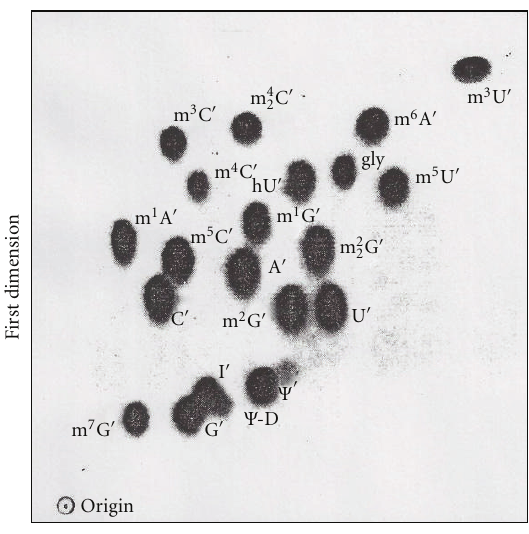
Figure 5: Two-dimensional map of standard nucleosides [9]. The [ 3 H]-labeled standard nucleoside derivatives are separated by two- dimensional thin layer chromatography. The first dimension is shown from bottom to top and the second dimension from left to right. Solvent systems are in the text. N (cid:2) represents trialcohol derivatives of representative